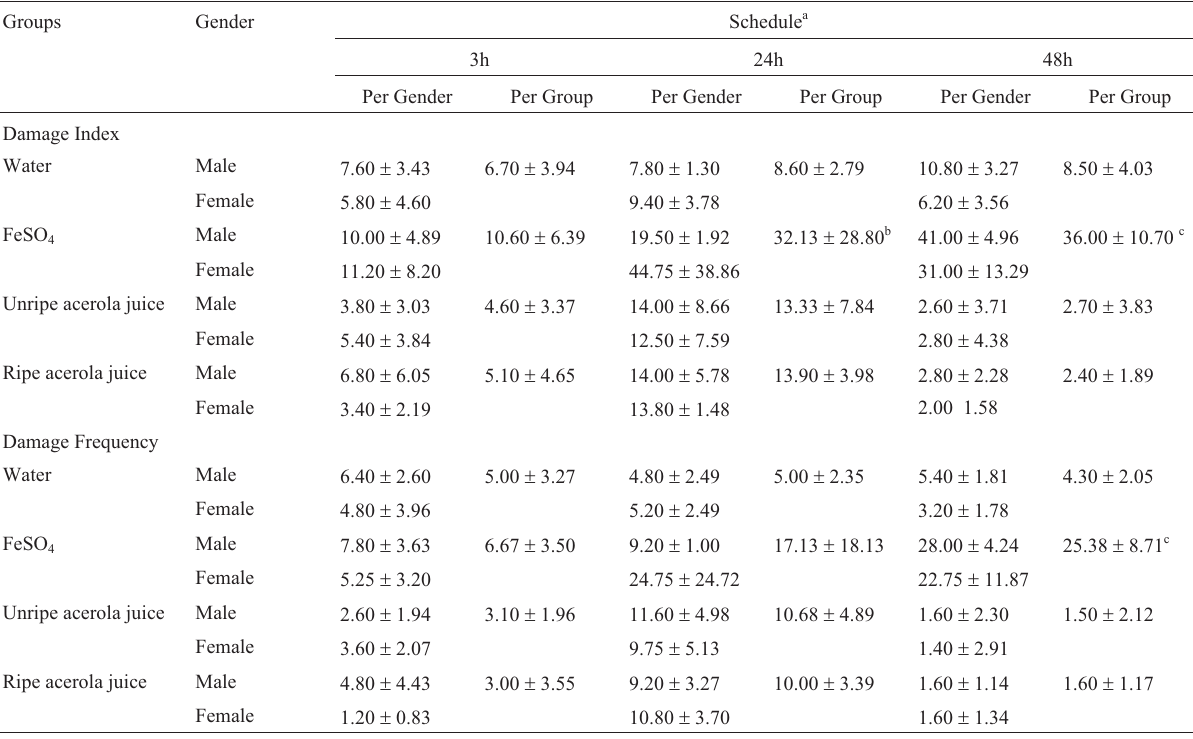
Table 2 - Comet assay parameters (damage index and damage frequency index; mean (cid:3) standard deviation) for blood samples of mice treated with unripe and ripe acerola juice. For each group, n = 10 (five males and five females), with 100 cells per animal. Groups